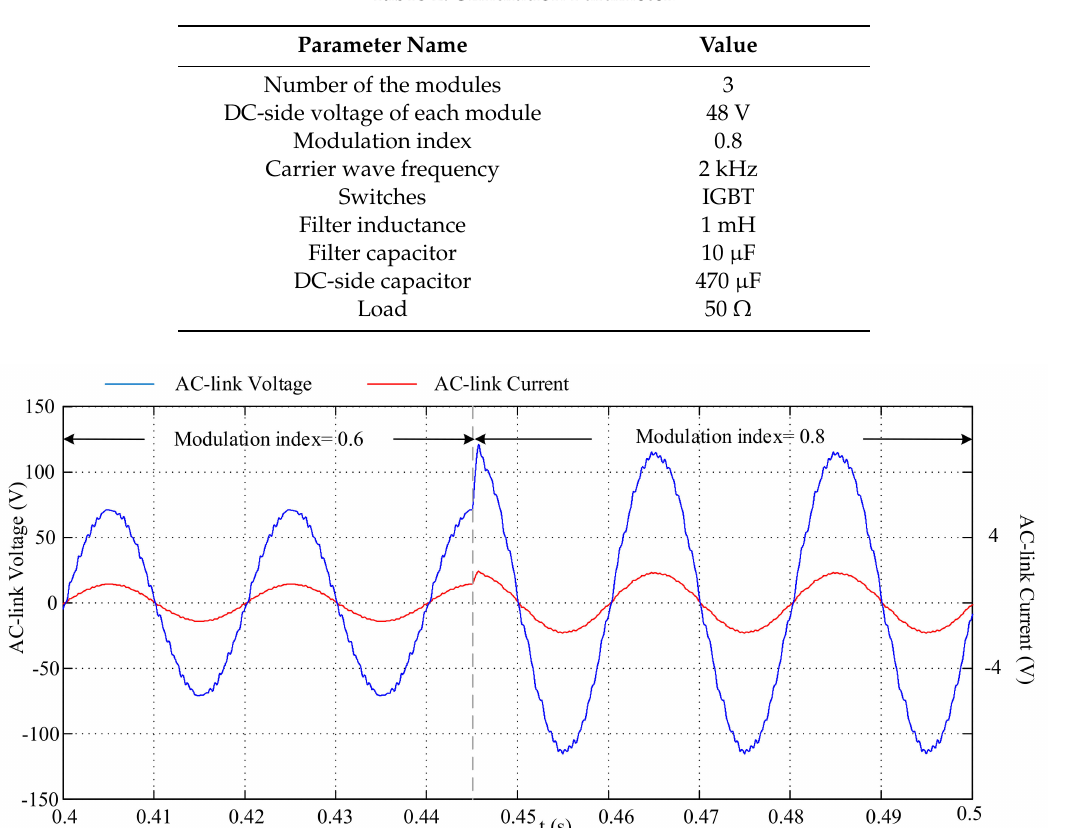
Table 2. Simulation Parameter.